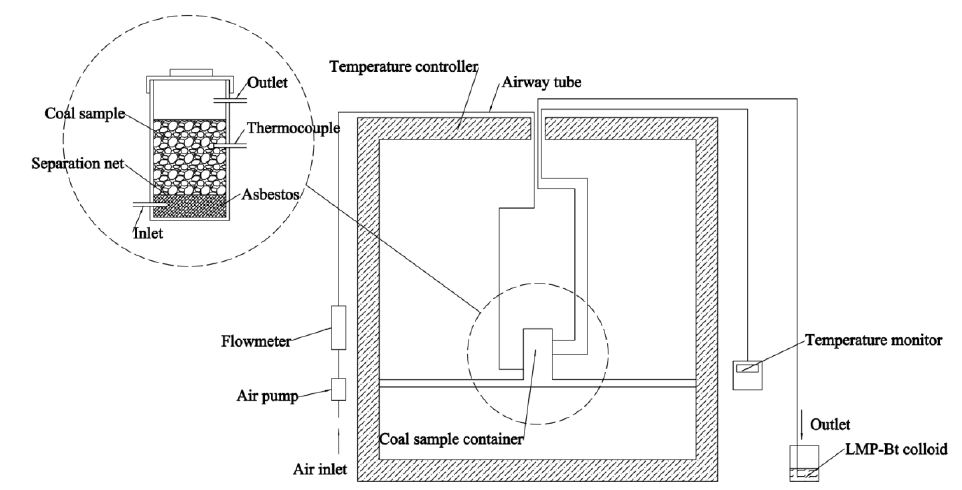
Figure 16. Verification of gelation by absorbing gas products of coal combustion.